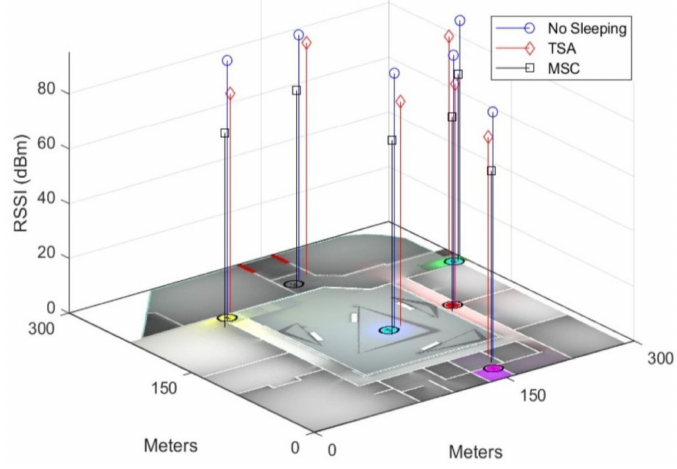
Figure 9. Analysis of the Zigbee sensors under no sleeping, TSA, and MSC for LEACH (energy-aware protocol).